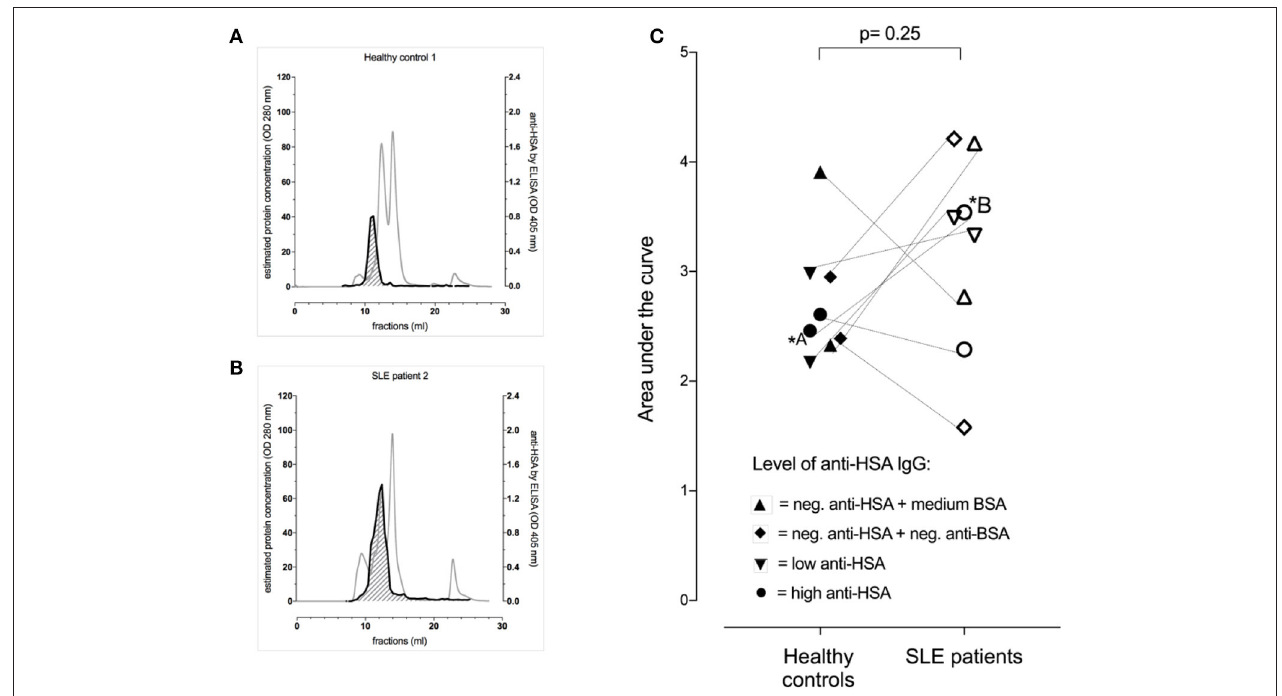
FIGURE 2 | Occurrence of albumin-IgG complexes in representative serum profiles (gray lines) after separation by FPLC of one of the healthy controls (A) and the corresponding (matched for anti-BSA IgG and anti-HSA IgG levels) SLE patient (B) . Both had high levels of anti-BSA IgG and anti-HSA IgG. The dark line indicated the signal intensity for albumin (HSA)-IgG complexes with the area under the curve (AUC) being shaded (AUC of the healthy control = 2.60 vs. AUC of the matched SLE patient = 4.21). (C) Demonstrates pooled data of 8 SLE patients and 8 healthy controls being matched for anti-HSA and anti-BSA levels as highlighted by the use of different symbols. Overall, there was no significant difference between the SLE patients and their corresponding healthy controls, but the SLE patients tended to have more albumin (HSA)-IgG immune complexes.